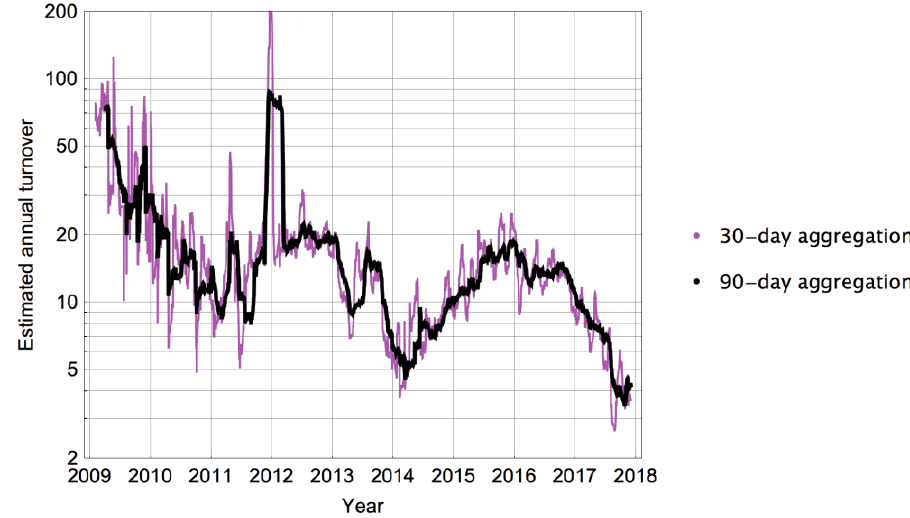
Fig. 2. Annual turnover of actively traded bitcoin for 30 day and 90 day aggregated transaction